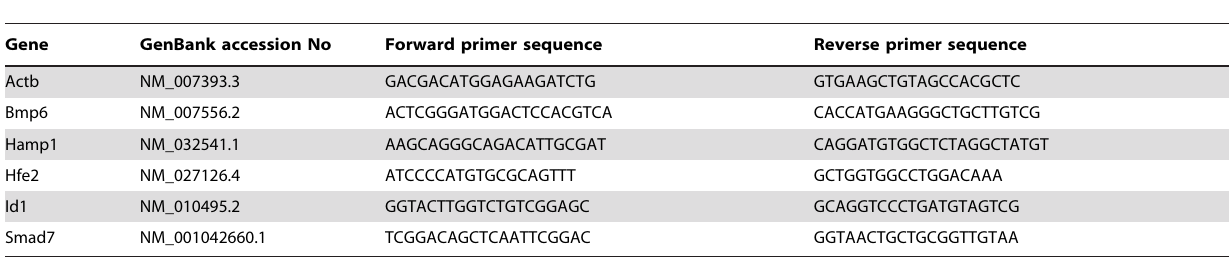
Table 1. List of primers used for qPCR or